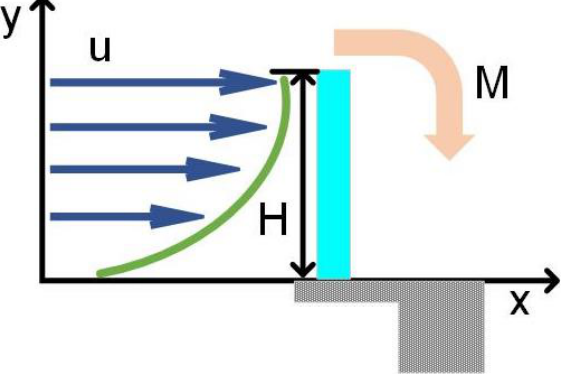
Figure 4. Schematic describing that a hair structure in a steady flow experiences a momentum generated by the drag force exerted on the hair.